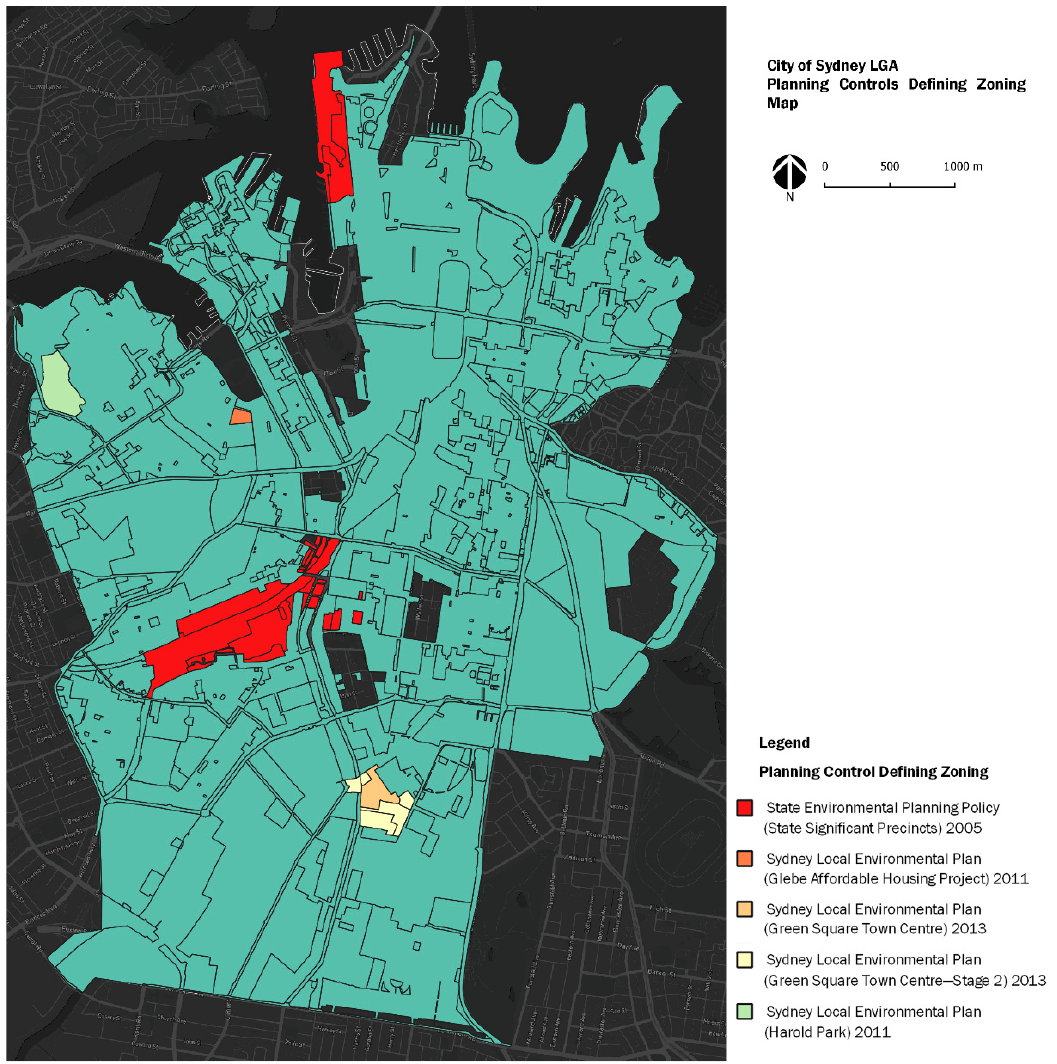
Figure 8. Map showing planning controls defining land zoning.